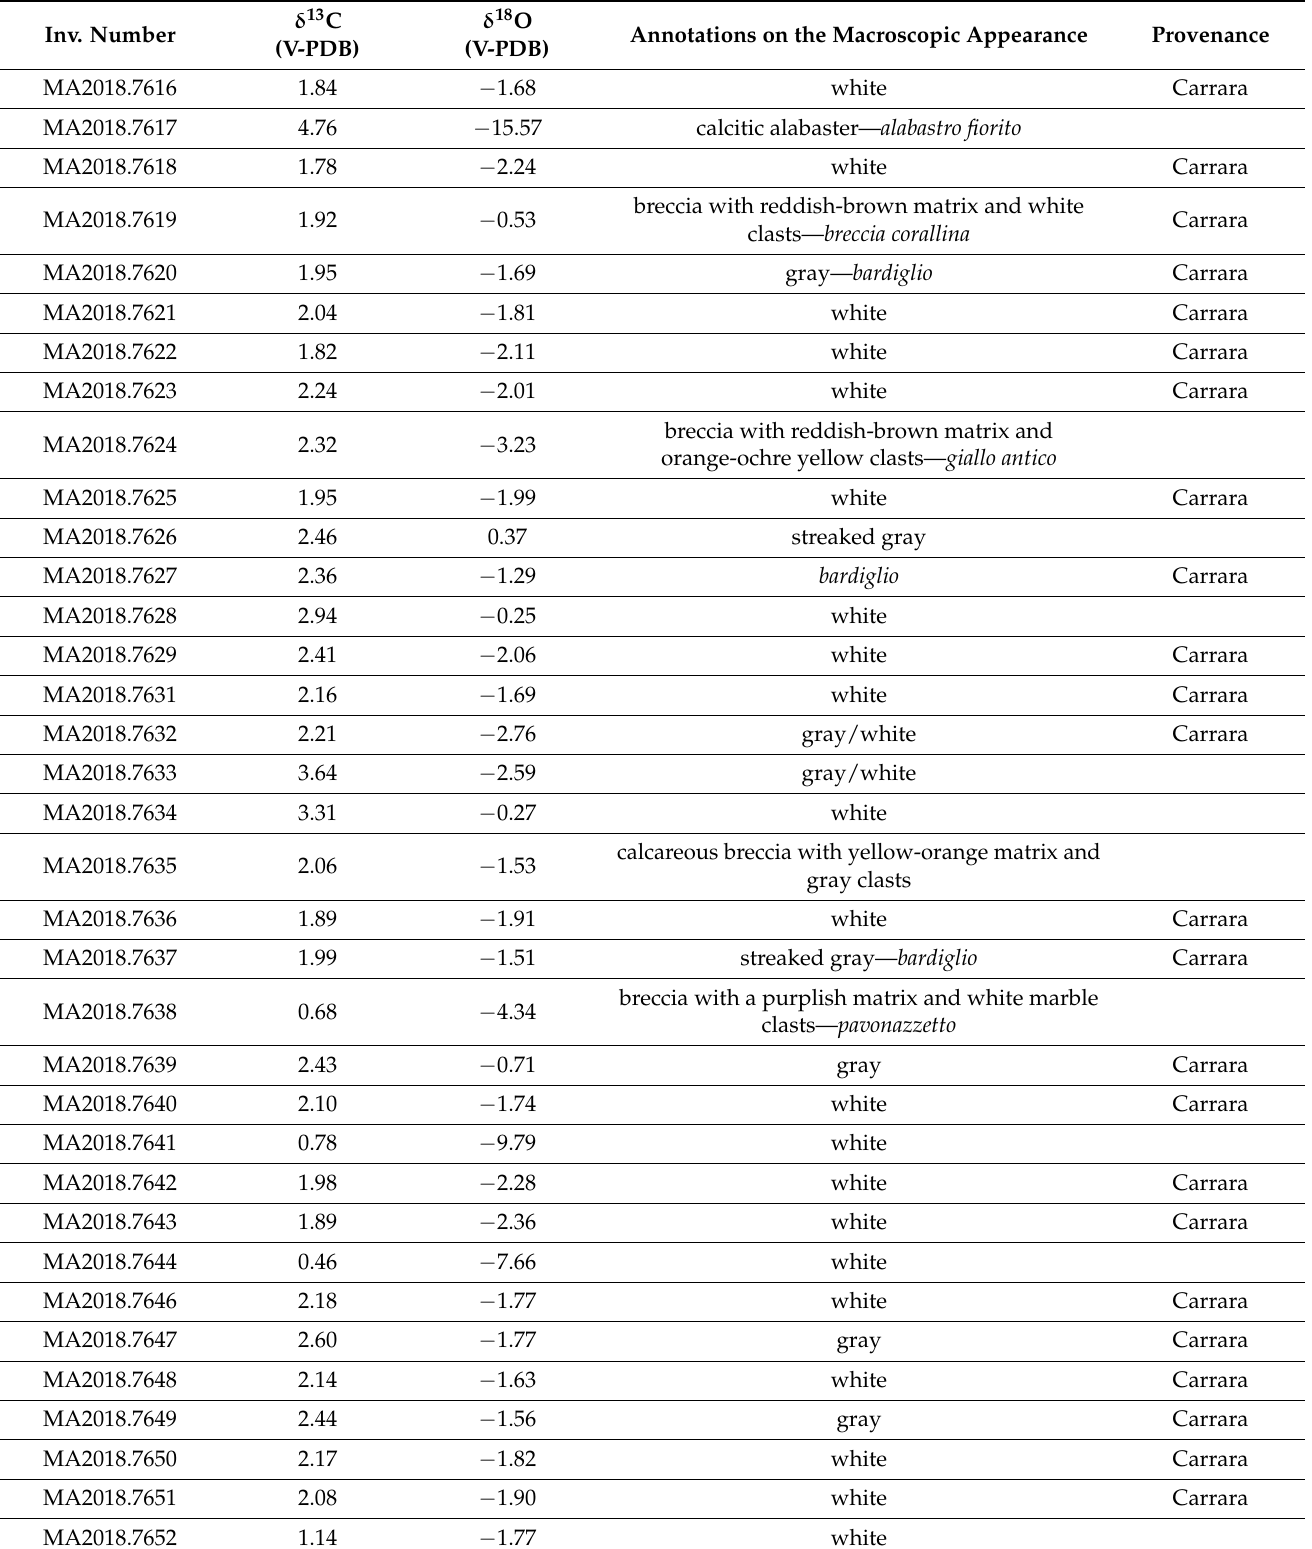
Table A2. Stable isotope results of the marbles of Al é ria and their macroscopic characteristics. The provenance of Carrara is based on isotopic information only; (n.d.—not determined). Inv.